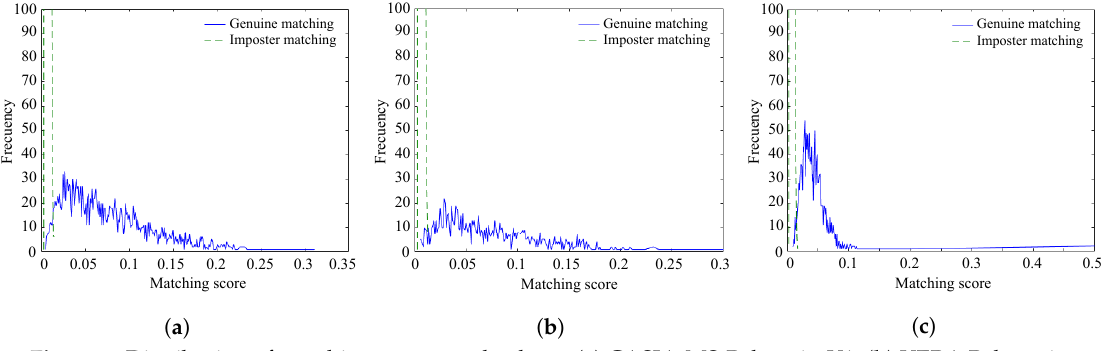
Figure 7. Distribution of matching scores on database: ( a ) CASIA-MS-PalmprintV1; ( b ) VERA Palm vein; and ( c ) PUT